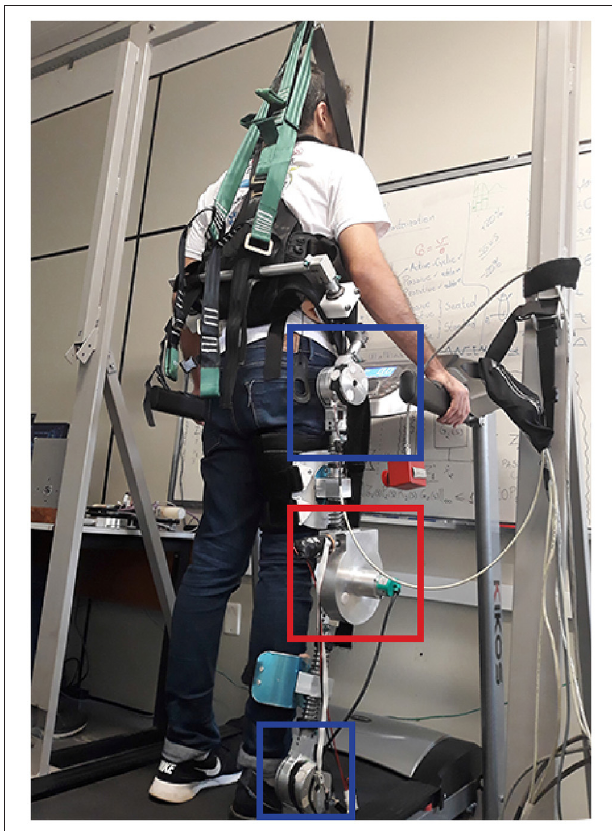
FIGURE 2 | Test setup with healthy subject wearing the right leg of the lower limbs exoskeleton ExoTao. The red box delimits the rotary SEA at the knee joint. The blue boxes depict the hip and ankle joints, which are not actuated. The robot is suspended by a mechanical structure in order to compensate for part of its weight, which leads to a more comfortable walk on the